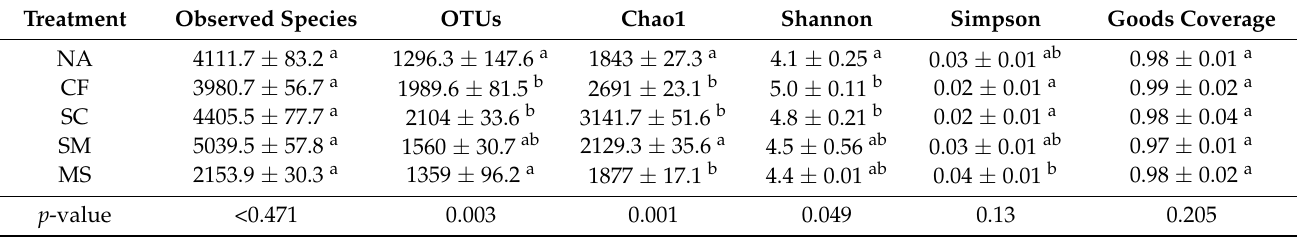
Table 5. Diversity indices of ammonia-oxidizing bacteria (AOB) at the similarity level of 97% under the influence of soil